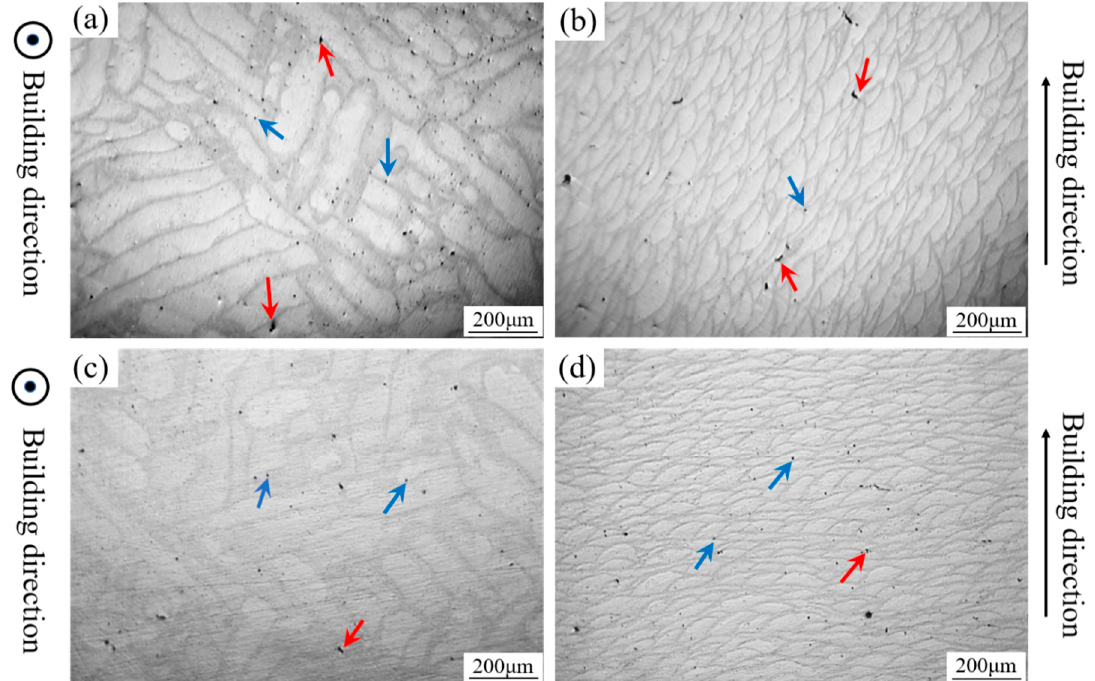
Figure 4. Typical pores of as-built specimens: pores on the ( a ) top and ( b ) side surface of the bulk specimen and internal pores of ( c ) top and ( d ) side surface of the bulk specimen. (Metallurgical pores and lack-of-fusion pores are pointed out by blue arrows and red arrows, respectively).